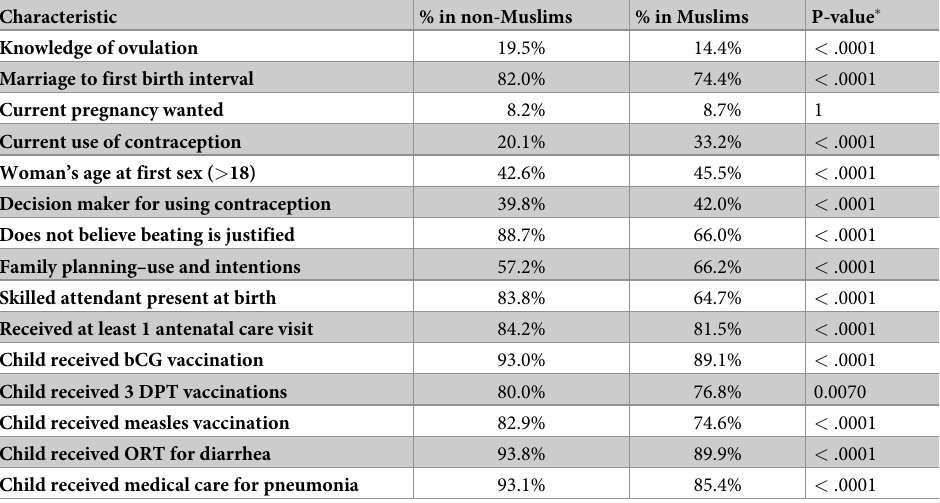
Table 3. Maternal and child health characteristics in Muslims and non-Muslims in 7 South Asian countries. Characteristic % in non-Muslims % in Muslims P-value � Knowledge of